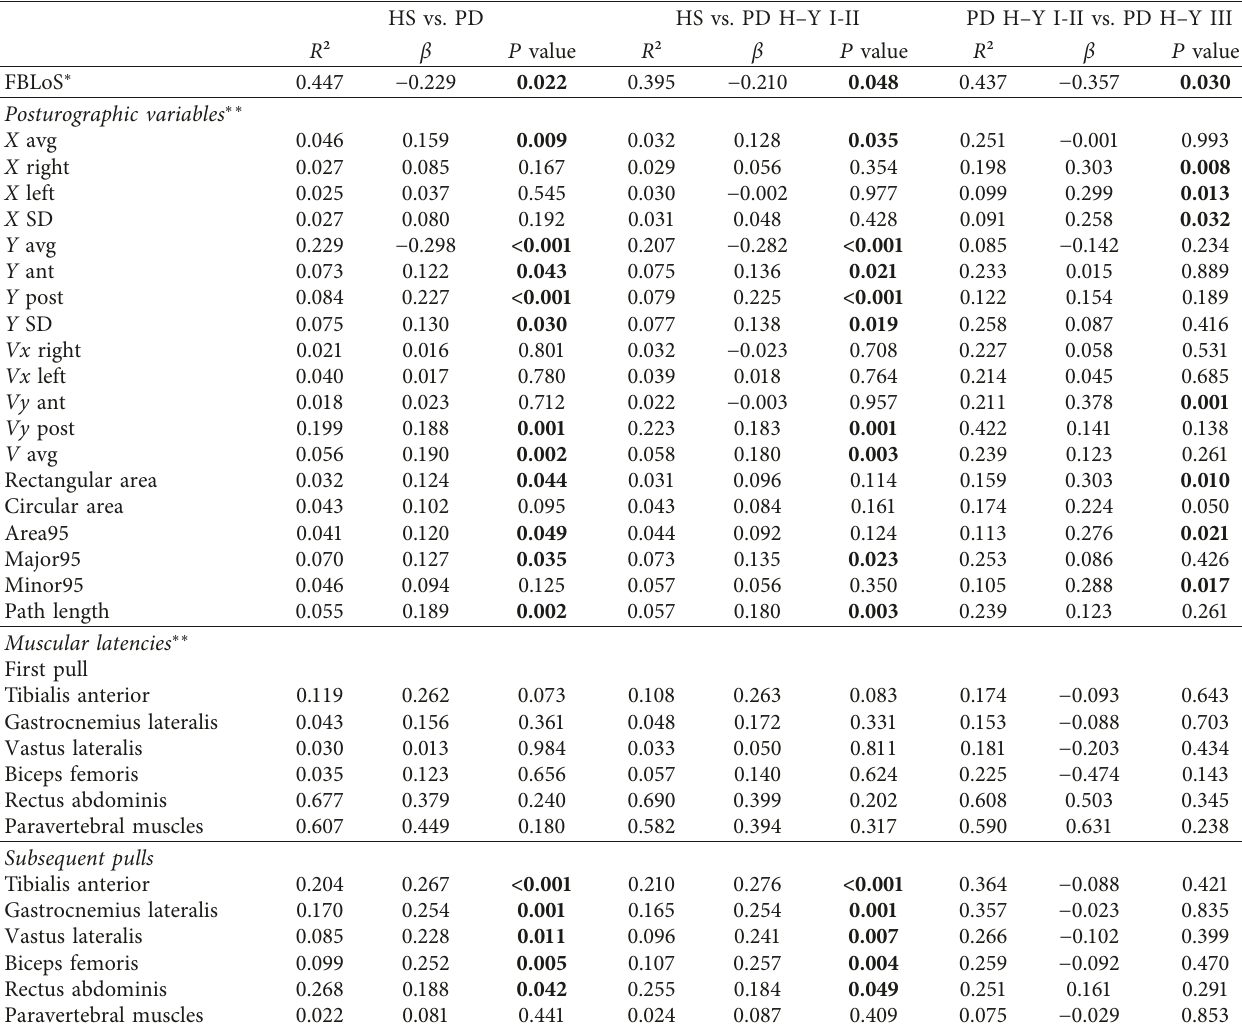
Table 3: Multivariate analyses. Comparisons of force to reach the backward limit of stability, posturographic variables, and muscular latencies between the different